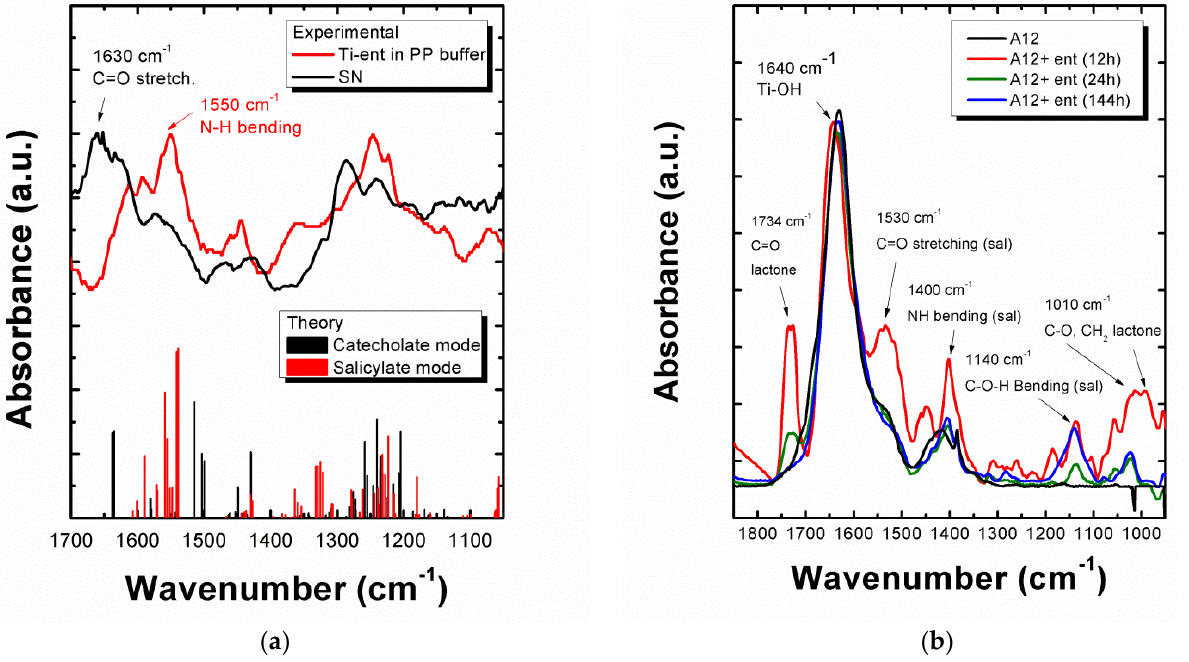
Figure 4. ( a ) FTIR spectra of the SN collected after 24 h of incubation at 37 °C of TiO 2 -A12 (5 mg.mL -1 ) in the presence of enterobactin ( ent ) (100 µM) in PP buffer compared to the spectra of a solution of Ti – ent complex (100 µM in PP medium). The peaks were assigned according to theoretical calculations of Ti – ent complexes in salicylate and catecholate modes (see Supplementary Materials, Section A). ( b ) FTIR spectra of the powders obtained after incubation of TiO 2 -A12 with ent (50 µM) at different incubation times. The spectra were normalized from the TiO 2 -specific peak at 1640 cm -1 (νTi– OH).